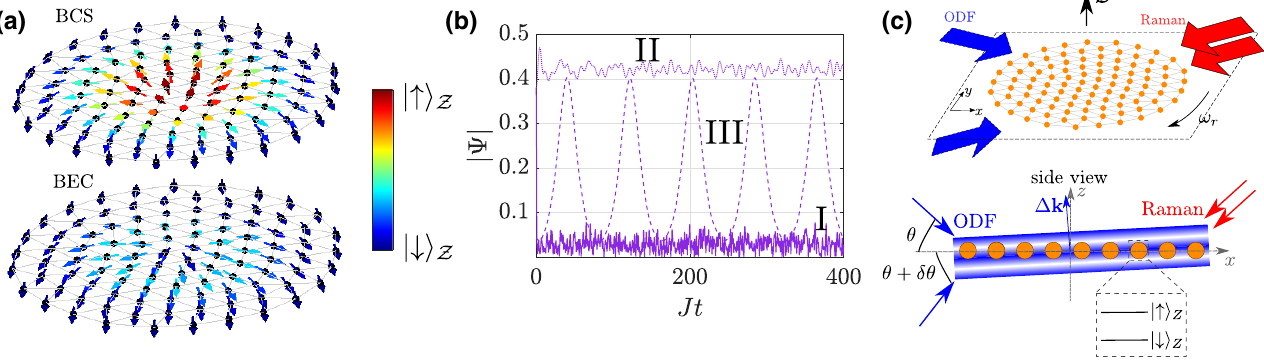
FIG. 1. Probing dynamical phases of p + ip superfluids using ion crystals in Penning traps. (a) The fermionic model is mapped on to spins encoded in the internal states of the ions, where spin up (down) represents the presence (absence) of a Cooper pair (Anderson pseudospin mapping). Here we show representative spin textures that can be engineered for the topologically nontrivial BCS and trivial BEC phases. (b) The dynamical phases are classified according to the long-time behavior of the magnitude of an order parameter—phase I, | (cid:5)( t ) | → 0; phase II, | (cid:5)( t ) | → nonzero constant; phase III, | (cid:5)( t ) | displays persistent oscillations. (c) Schematic of our experimental proposal. State initialization, p -wave interactions and readout are all achieved using appropriate parameters for a pair of optical dipole force (ODF) lasers and a pair of copropagating Raman lasers. In contrast to prior implementations, the ODF difference wave vector δ k has both an out-of-plane and in-plane component (see side view). The result is a tilted traveling-wave lattice that crosses the crystal plane slightly obliquely and thus couples the ions’ electronic degrees of freedom, the out-of-plane center-of- mass mode, and the in-plane crystal rotation. The spin-space directions Z in panel (a) and Z in panel (c) are related by a rotation, as discussed in Sec.